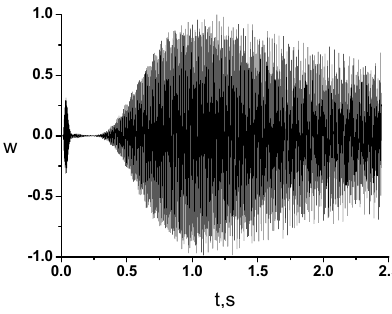
Figure 3. The oscillations inside the initial cylinder.